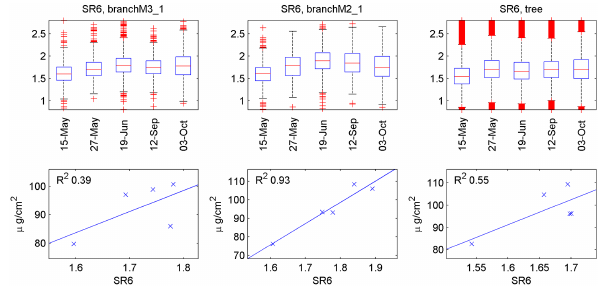
Figure 5. Same as previous figure but this time using the SR6 spec- tral